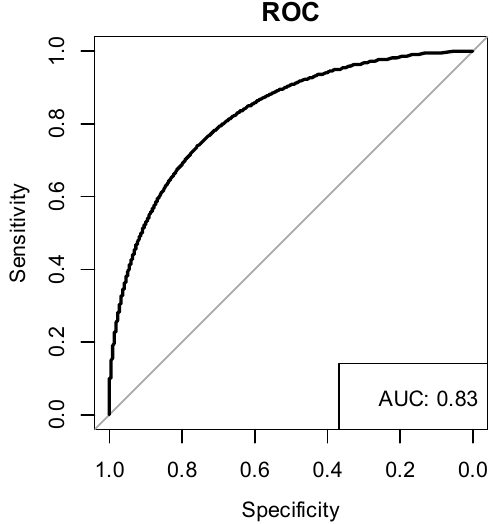
Figure 3. ROC curve of the HAG index with an AUC of 0.83. Table 4. ROC curve result for the HAG Table 3. Results of the multivariate logistic regression for the risk profile.